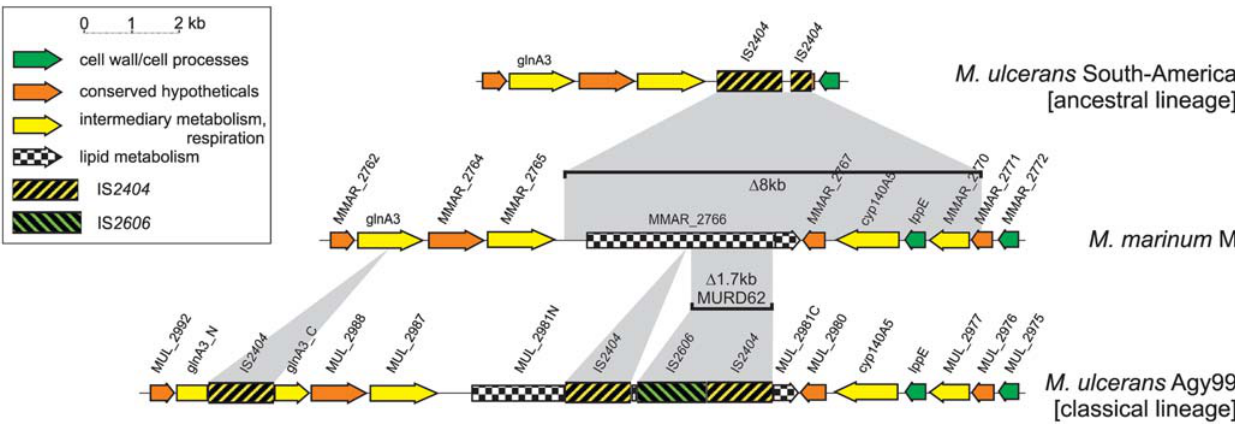
Figure 1. Comparison of CDSs (coding sequences) in RD (region of difference) 1 between M.marinum M (centre line), M.ulcerans haplotype South America (upper line, a member of the ancestral lineage) and M.ulcerans Agy99 (bottom line, a member of the classical lineage). Deletions (bars) and insertions as compared to the M. marinum M sequence are indicated by grey areas. Note that ‘‘MURDs’’ ( M. ulcerans regions of difference) only define differences between M. marinum M and M. ulcerans Agy99, member of the classical lineage. Therefore, regions varying between M. ulcerans strains should be described as ‘‘RDs’’ (region of differences).